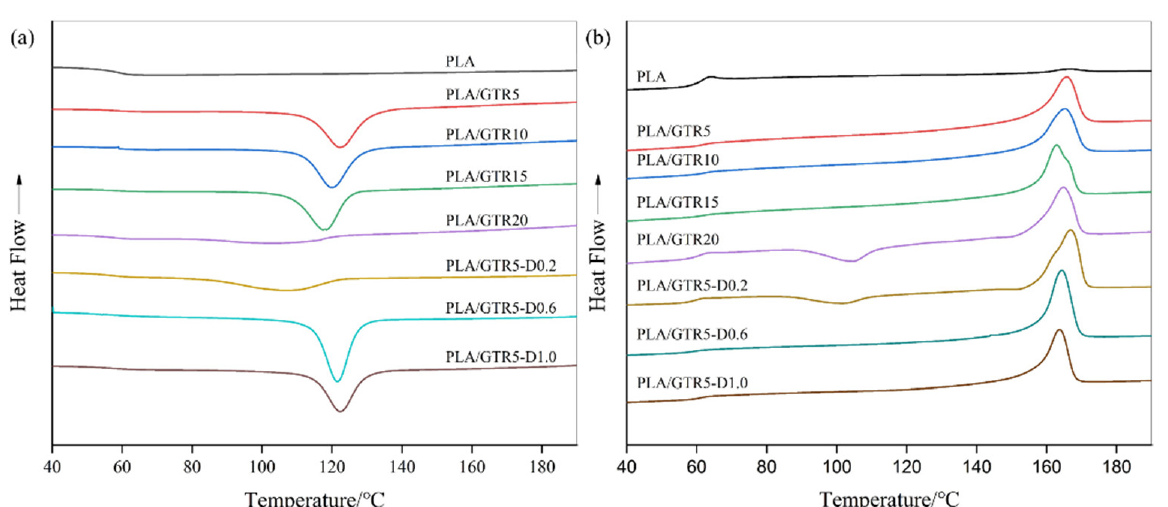
Figure 5. Mechanical properties of neat PLA and PLA/GTR (95/5) as a function of DCP content: ( a ) Tensile strength. ( b ) Elongation at break. ( c ) Notched Izod impact strength.